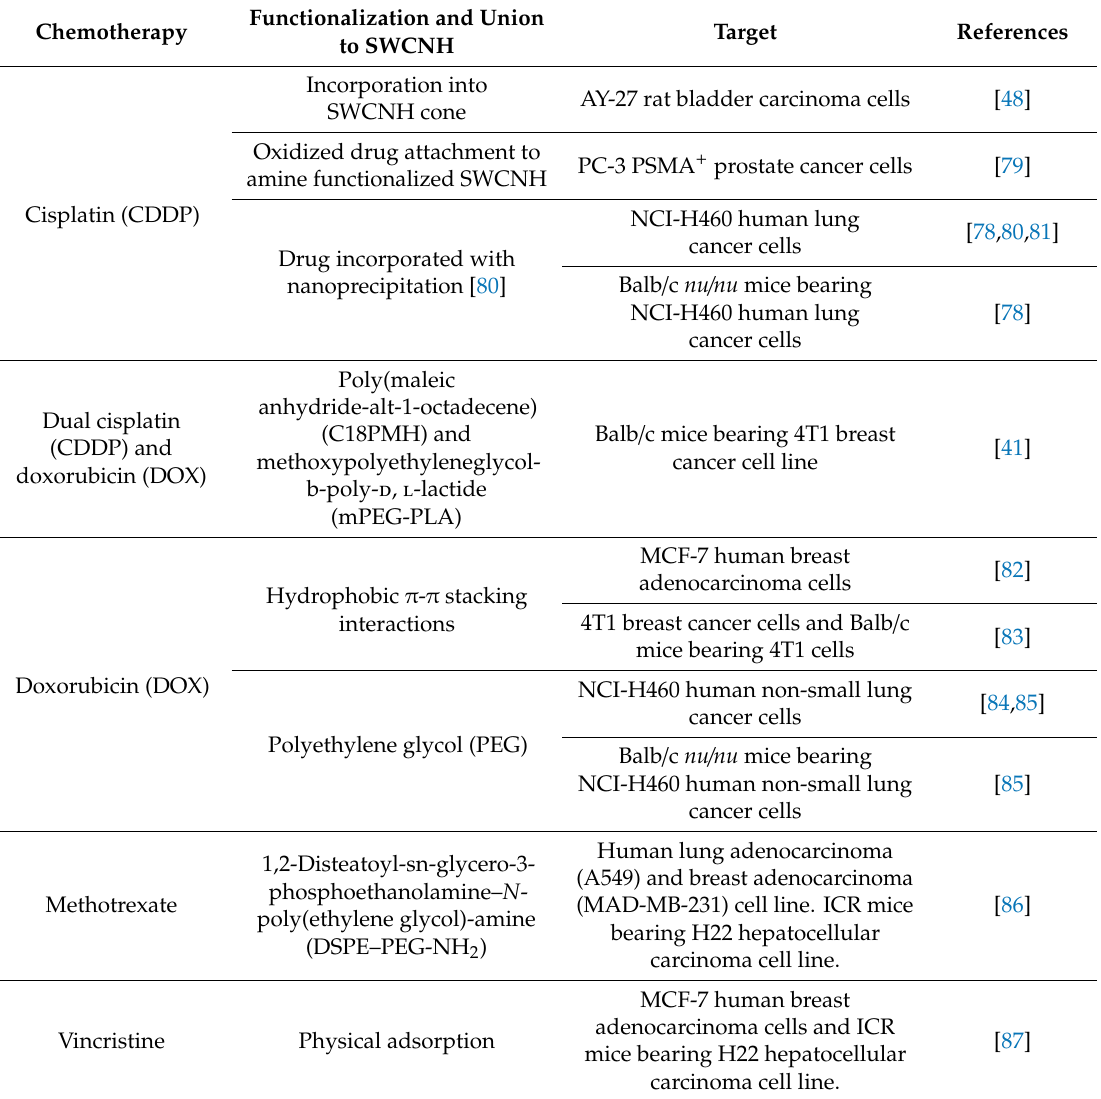
Table 2. Use of SWCNH with chemotherapeutic